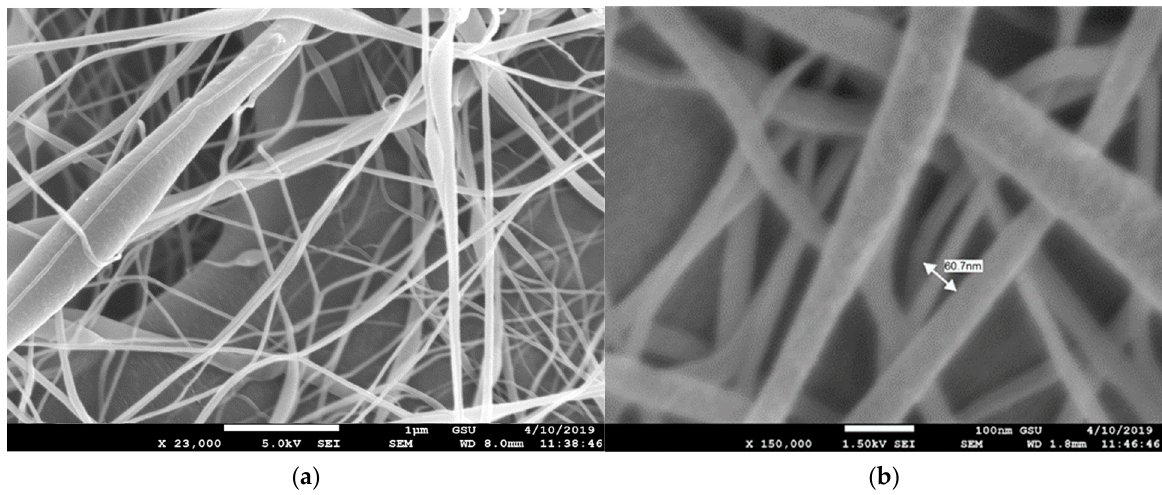
Figure 6. SEM image of MWCNT-reinforced PVDF nanofibers ( a ) at 23,000 magnification and ( b ) at 150,000 magnification .